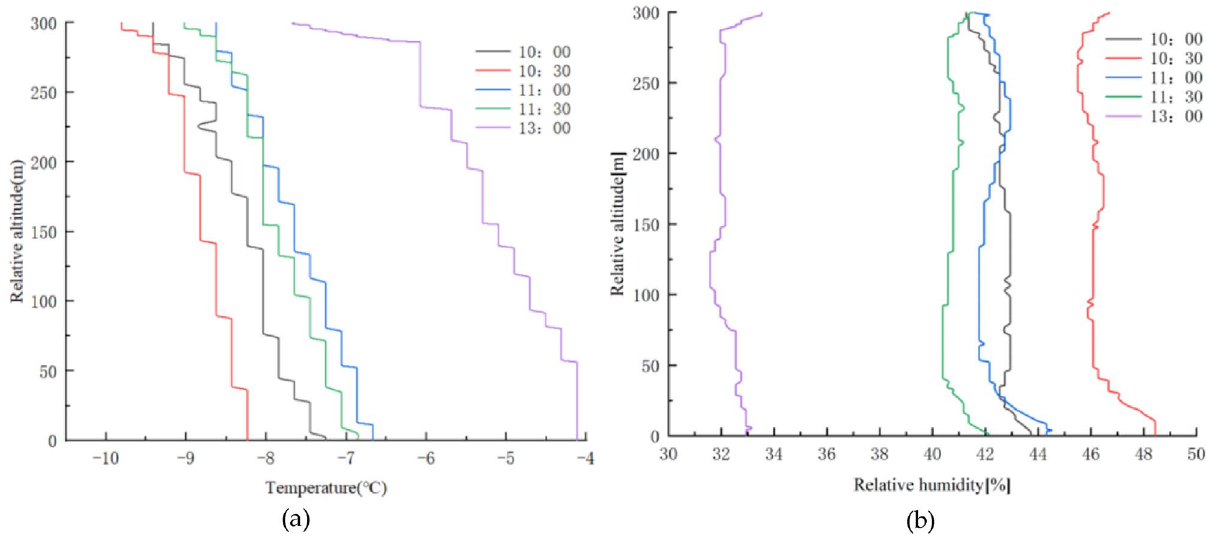
Figure 5. Temperature, relative humidity, and altitude relationship in winter; ( a ) Temperature-altitude relationship; ( b ) Relative humidity-altitude